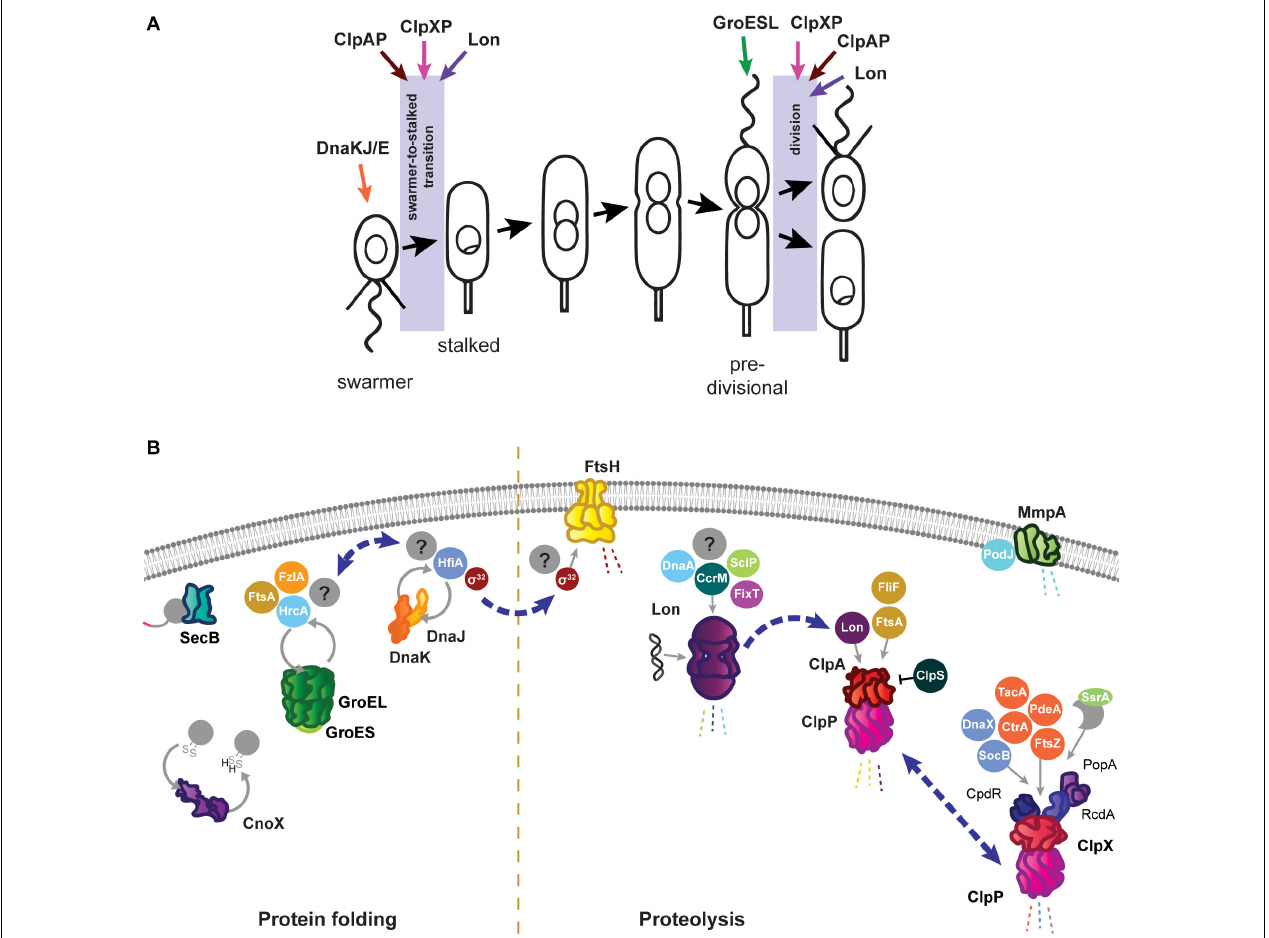
FIGURE 1 | Roles of the Caulobacter crescentus PQC network in cell cycle progression and development. (A) The asymmetric life cycle of Caulobacter . Points where mechanisms have been identified where specific PQC proteins contribute to cell cycle progression are indicated with colored arrows. (B) Specific tasks of individual PQC network proteins in development and cell cycle progression during optimal conditions. Client proteins are indicated in circles where they are known, and by question marks where additional substrates have yet to be identified. Holdase cycling is indicated with gray circular arrows, and degradation with dashed lines. Blue dashed arrows indicate points of interaction between PQC network proteins. Membrane and DNA images created with Biorender